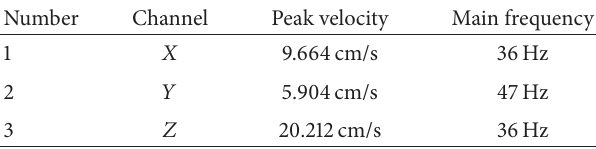
Table 2: Peak velocity and main frequency (WBV).